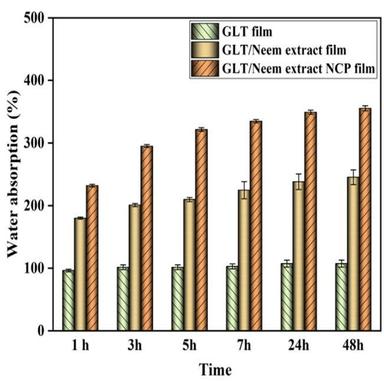
WAC of GLT film, GLT/Neem extract film, and GLT/Neem extract NCP film.